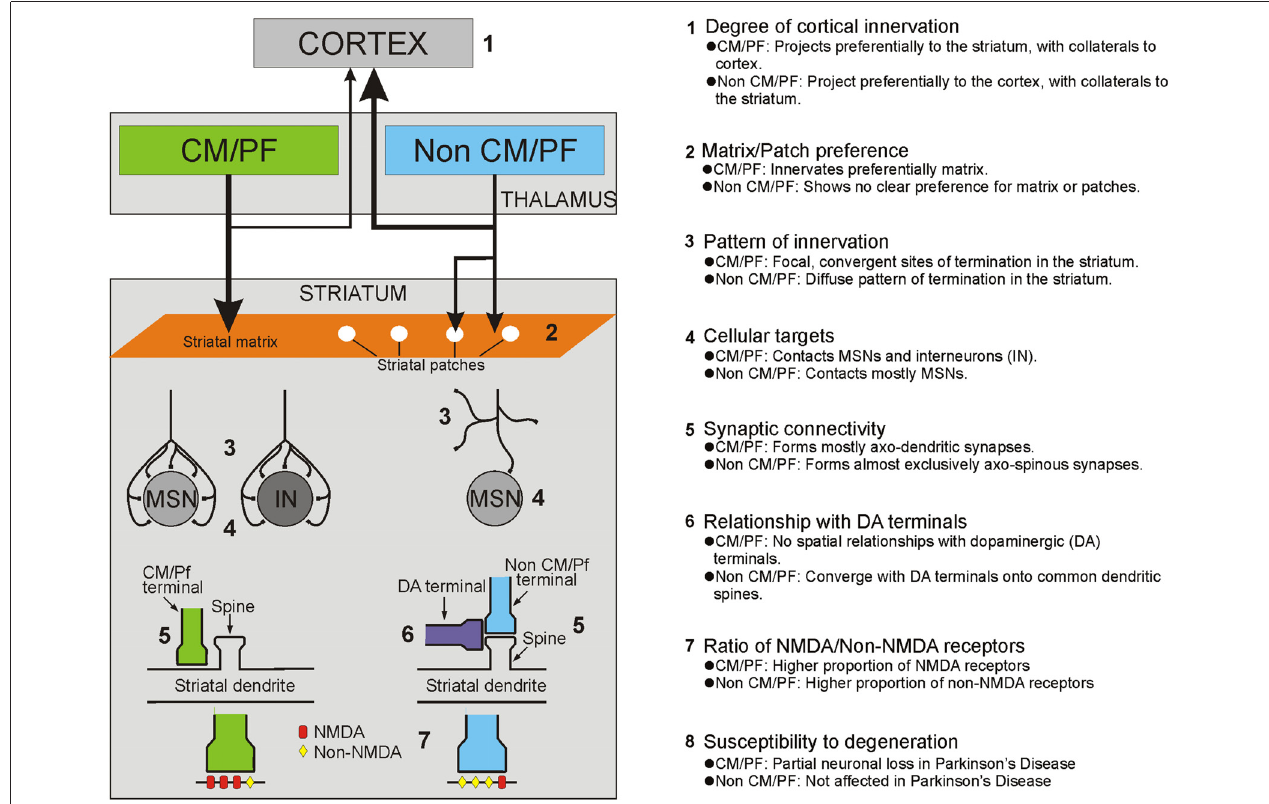
FIGURE 1 | Summary of the anatomical, functional and pathological characteristics that differentiate thalamostriatal projections from the CM/Pf vs. other thalamic nuclei (i.e., non CM/Pf).